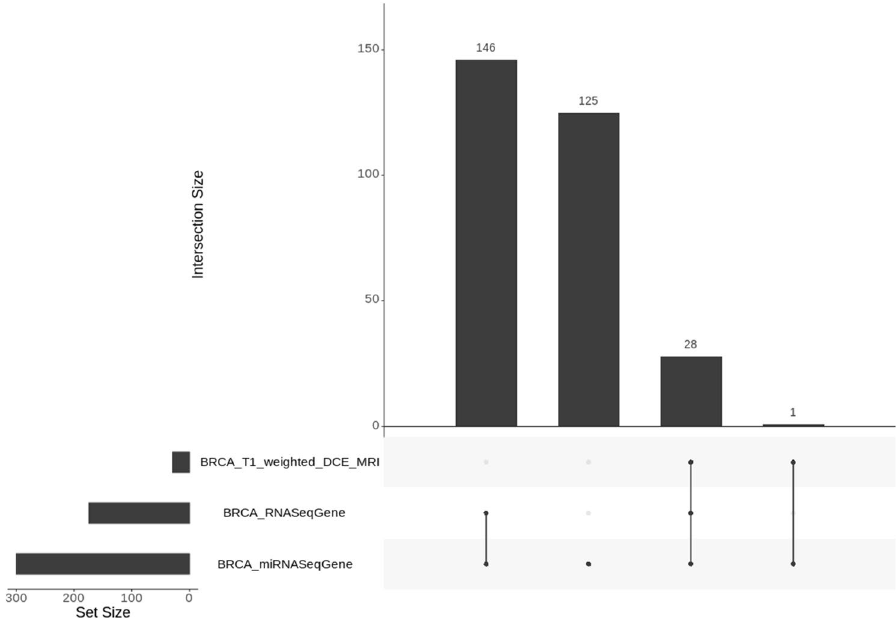
Figure 3. Generalized Venn diagram. A generalized Venn diagram for TCGA Breast Cancer sample membership in multiple assays performed by RNAseq, miRNAseq and Magnetic Resonance Imaging experiments. The visualization of set intersections was performed using the UpSet matrix design using UpSetR package. The figure is generated by using R software version 3.6.1 (https ://www.r-proje